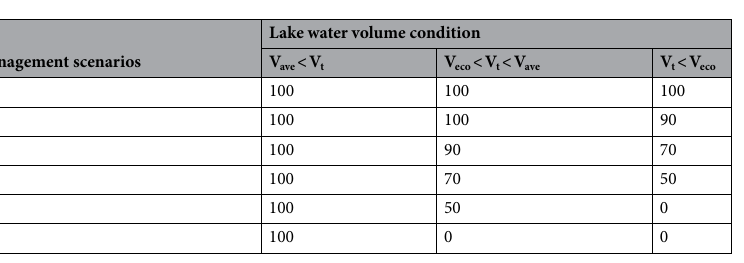
Table 3. Six management scenarios and their lake water control volumes (adopted from 22,23 ). V t = lake volume in month t (million m 3 ); V ave = long-term average of the lake volume in month t (million m 3 ); and V eco = lake ecological volume in month t (million m 3 ) (i.e., the minimum lake water volume for the survival of living organisms in the Lake Urmia